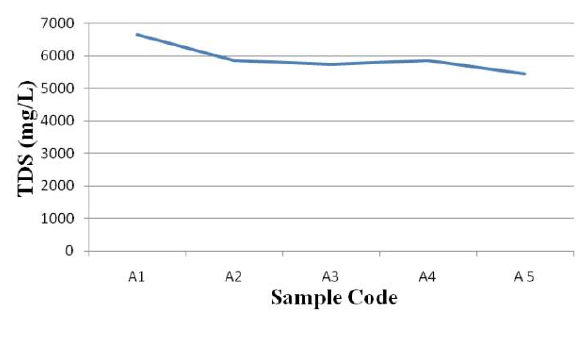
Figure 5. TDS in samples